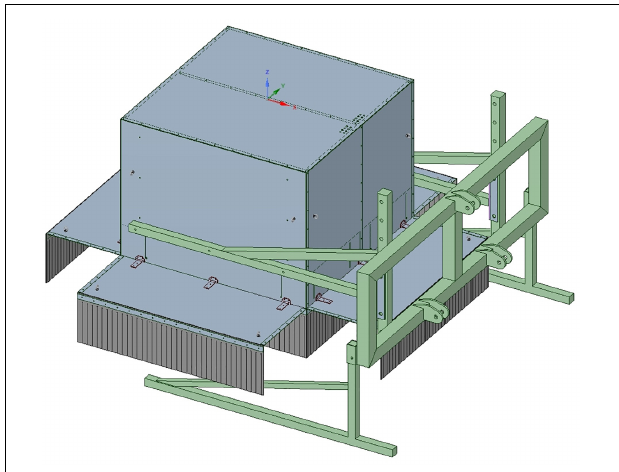
FIGURE 2 | Drawing of the measurement box, consisting of two compartments, the first one for the hyperspectral camera and the second one for an RGB-D imaging system. Ambient light is blocked by two rows of rubber flaps. The box can be mounted on the front of a tractor.